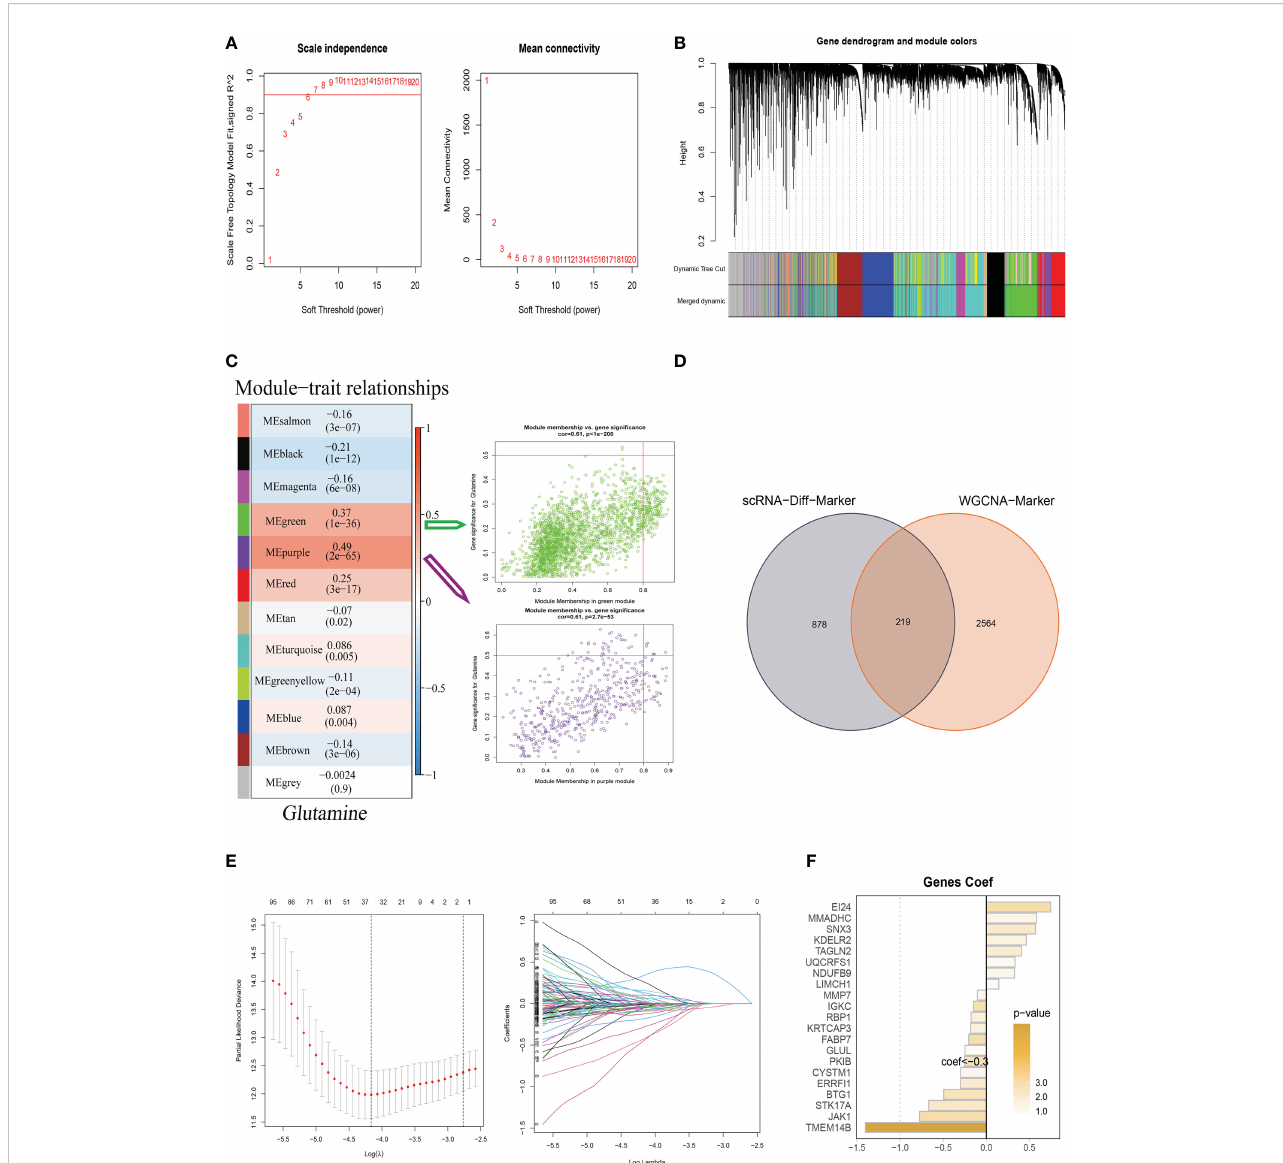
FIGURE 3 Weighted Co-Expression Network Analysis and construction Glutamine-Related Prognostic Model. (A – C) Weighted Co-Expression Network Analysis. The green and purple modules were most associated with glutamine, of which 2,783 genes were extracted. (D) The intersection of genes obtained in single- cell analysis and bulk-RNA analysis. (E) LASSO Cox regression analysis to develop the prognostic model. (F) The role of twenty-one model